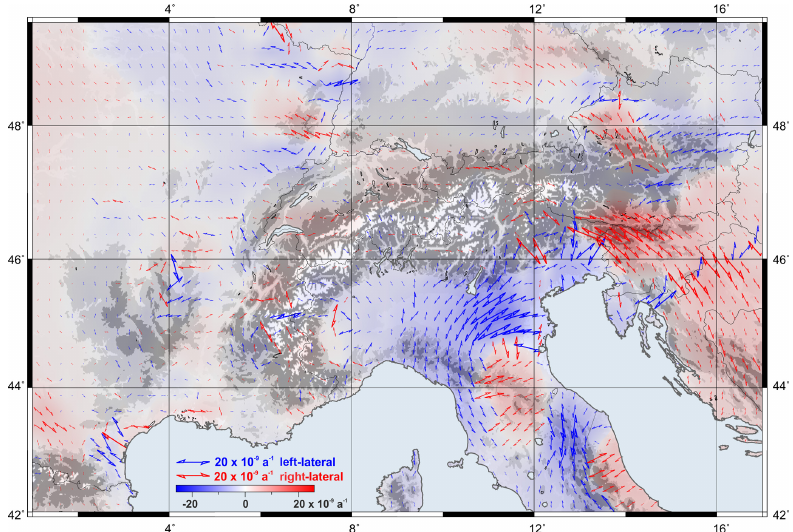
Figure 16. Shear strain distribution in the Alpine region. Blue and red shades represent the left-lateral and right-lateral shear, respectively. For illustration purposes, the left-lateral shear is considered as negative and the right-lateral shear as positive. Topography after the ETOPO1 model (Amante and Eakins,